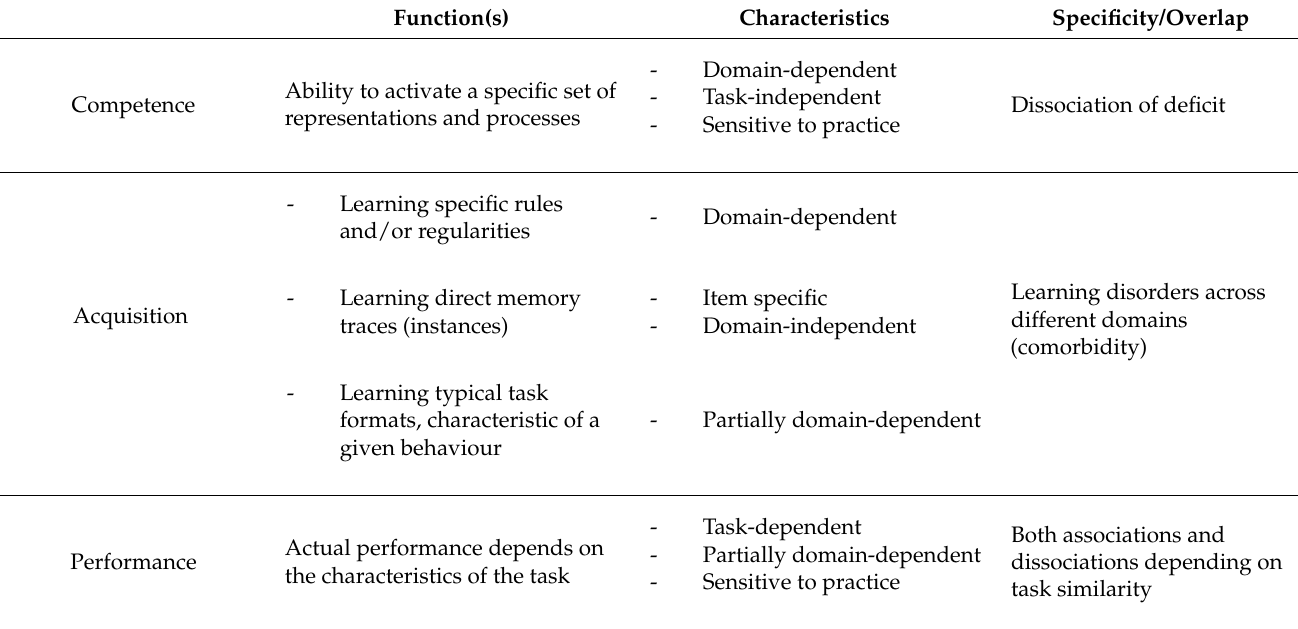
Table 1. Main functions and characteristics of competence, acquisition and performance levels as related to individual differences in learning skills and comorbidity of learning